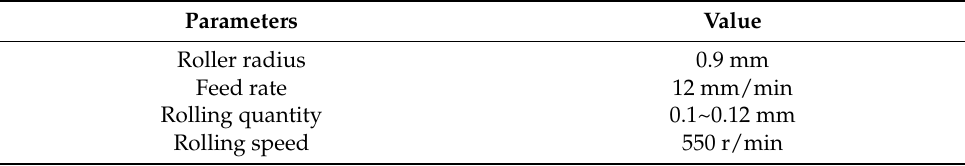
Table 1. Parameters of deep rolling used in this